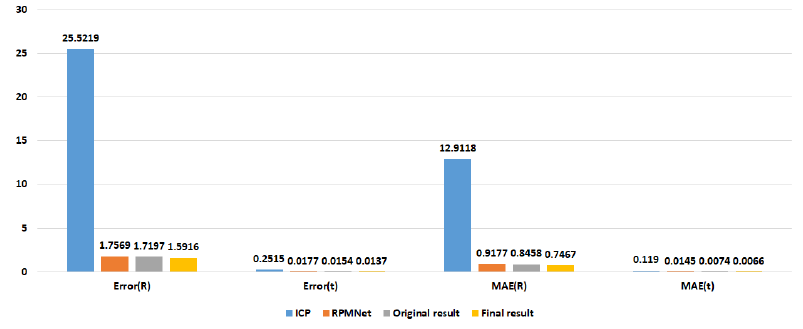
Figure 12. Registration results on ModelNet40 with Gaussian noise.